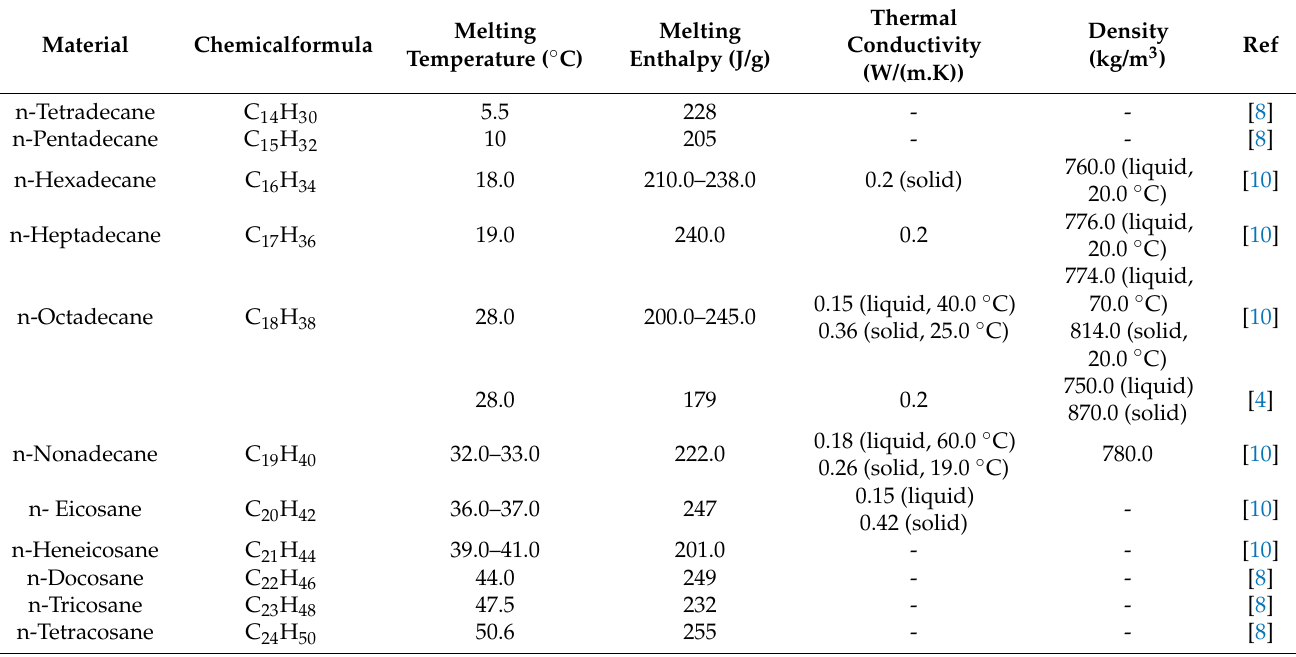
Table 1. Thermal properties of some